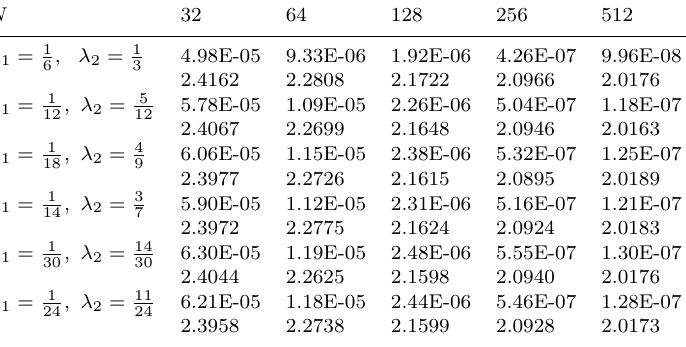
Table 4. Maximum absolute error and order of convergence for Example 2 with ε = 2 − 3 , δ = 0 . 5 ε N 32 64 128